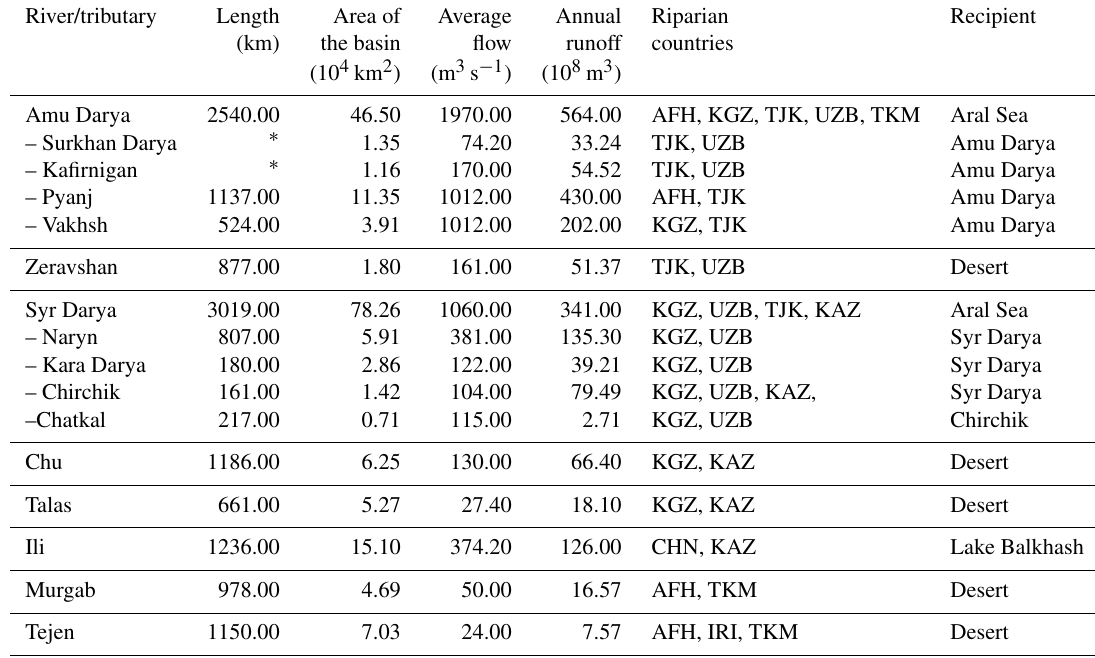
Table 1. Transboundary rivers and tributaries in Central